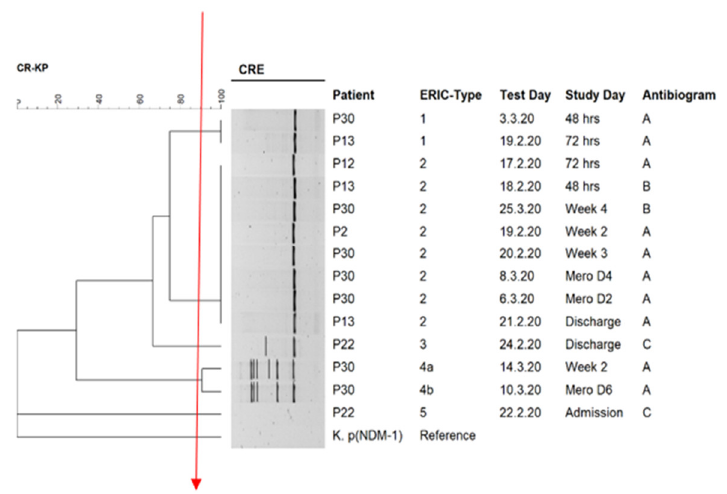
Figure 2. ERIC/PCR dendrogram for CPKP isolates ( n = 14). Isolates clustered into five main clusters based on the similarity index of 90%. The solid red line indicates the ERIC-type cut-off. Antibiogram: A = AMP-AMC-TZP-CXM-CXM-AX-FOX-CTX-CAZ-FEP-ERTA-IPM-MEM-CIP-NIT-SXT; B = AMP-